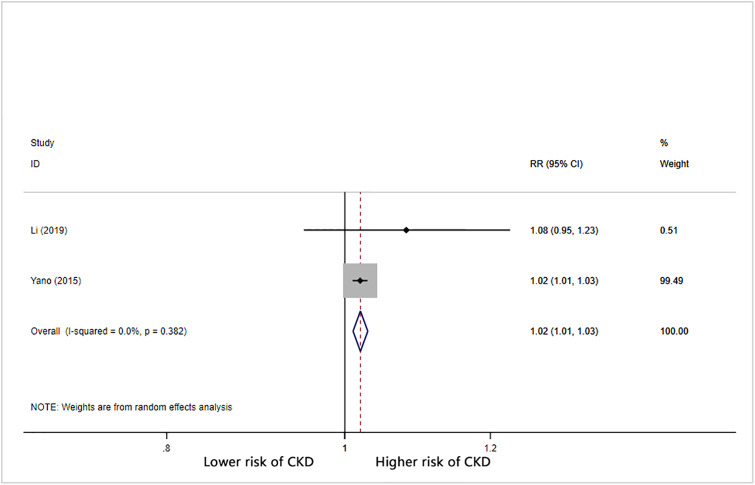
Forest plot of relationship between 1% increment in CV-DBP and risk of CKD.Boxes represent the Relative risk (RR) and lines represent the 95% Confidence Intervals (CIs) for individual studies. The area of each square is proportional to study weight. The diamonds and their width represent the pooled RRs and the 95% CIs, respectively.